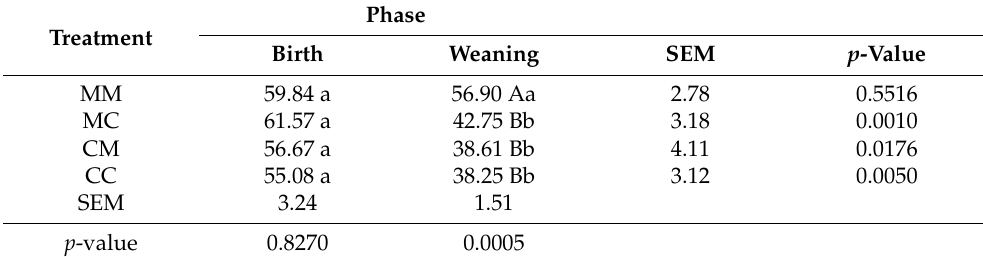
Table 5. Concentration of serum BDNF (pg/mL) of piglets at birth and 21 days (weaning), descen- dants of sows submitted to the CC treatments: control-control; CM: control-music; MC: music-control; MM: